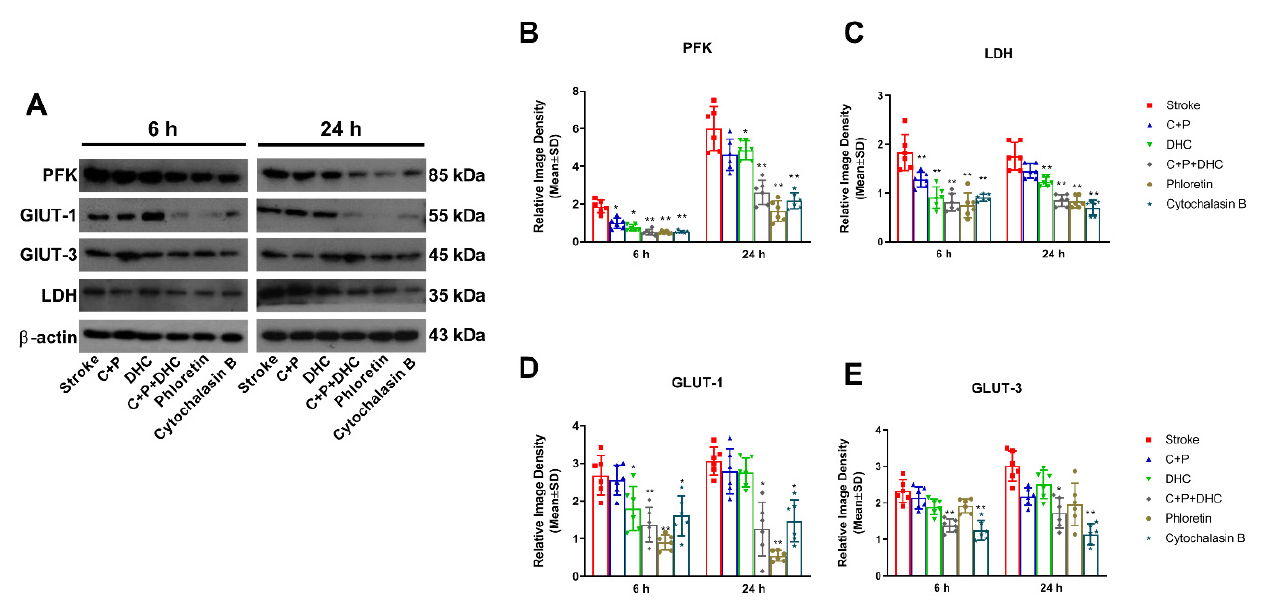
Figure 5. Effect of pharmacological hypothermia on glycolytic enzymes. ( A ) Representative Western blot bands of glycolytic enzymes. PFK ( B ), LDH ( C ), GLUT-1 ( D ), and GLUT-3 ( E ) levels were significantly reduced by pharmacological hypothermia, phloretin, and cytochalasin B. Data are presented as mean ± SD, * p < 0.05, ** p < 0.01, as compared to stroke group ( n =